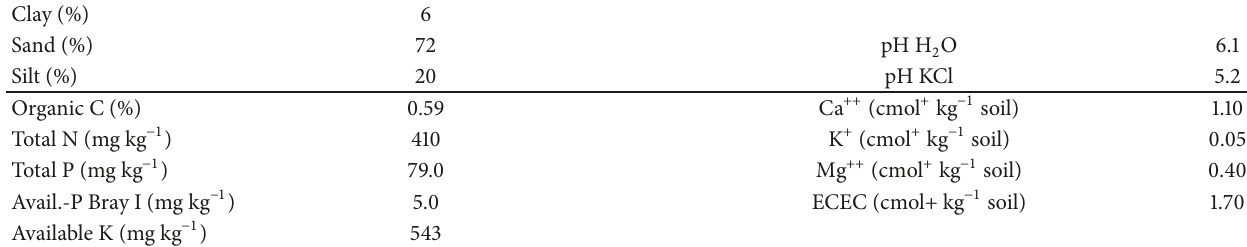
Table 1: Main physicochemical characteristics of the topsoil (0-20 Cm).